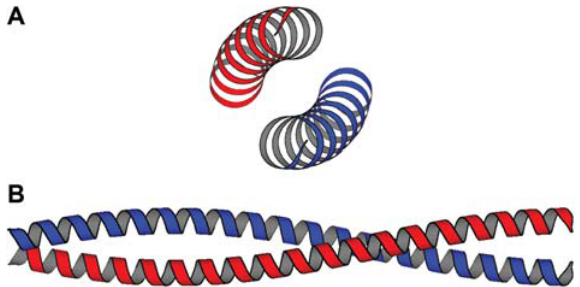
Figure 1 Ribbon representations of an idealized coiled coil com- puted using the principles in Crick’s equations as described in Ref. (13). (A) View of a 28-residue coiled coil down the supercoil axis. (B) Side view of a long segment of 1.5 superhelical turns. Figures drawn with MOLSCRIPT (105).